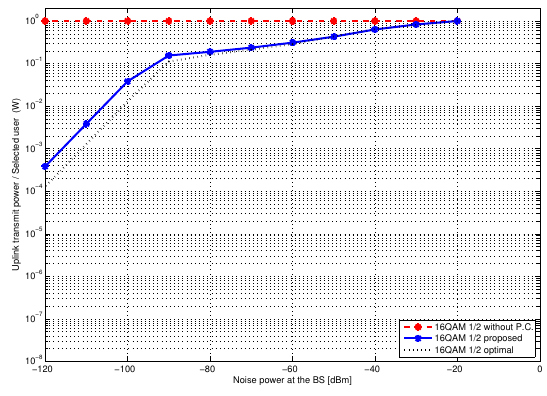
Figure 14. Transmit power of 16QAM-1/2 versus noise